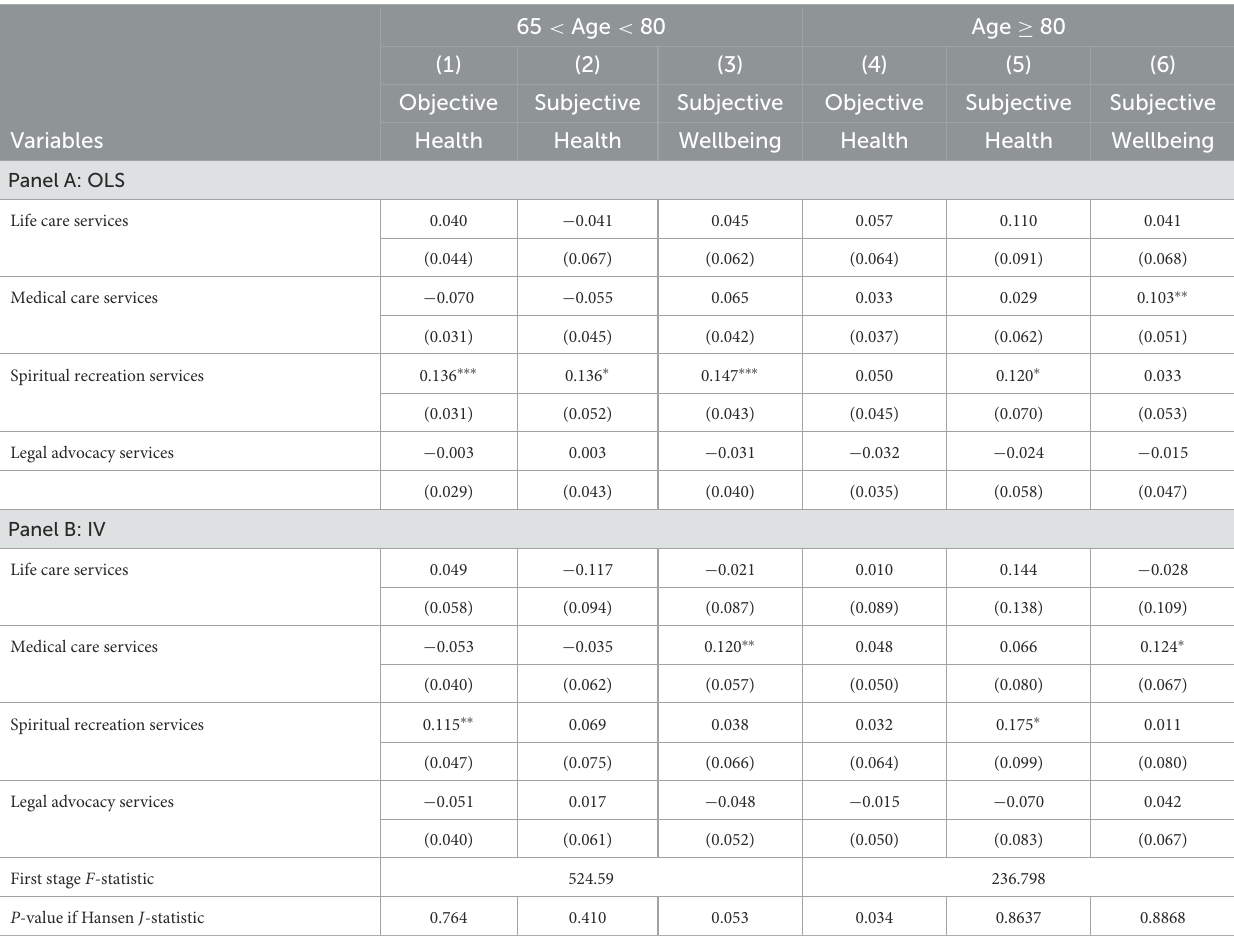
TABLE 7 Heterogeneous effect by